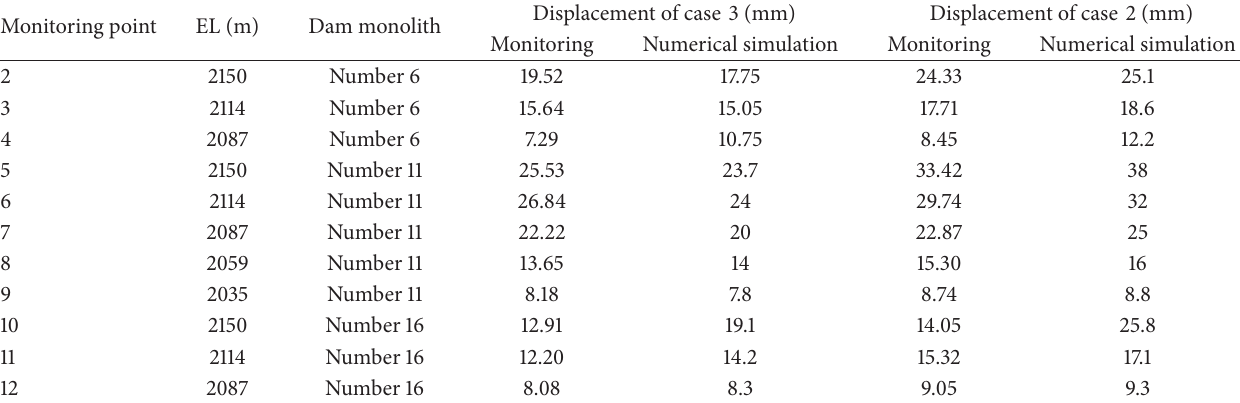
Table 3: Field monitored displacement values and numerical results for solving the objective function 𝑇(𝑃) . Monitoring